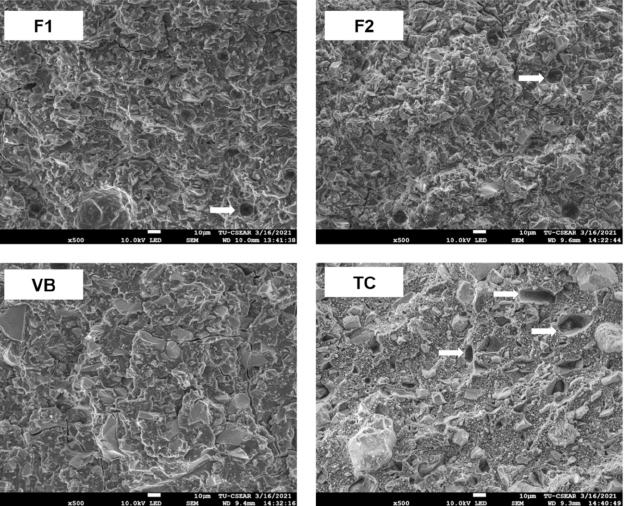
Figure 8. SEM images of fracture surfaces from a representative specimen of each group. Voids (arrows) are seen on the fracture sites of F1, F2, and